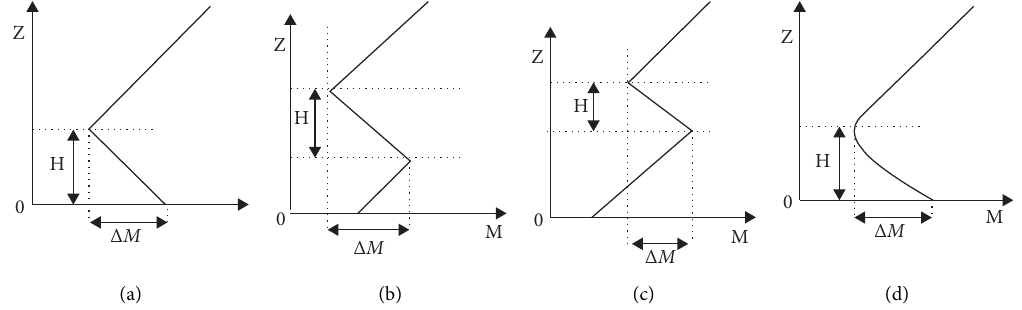
Figure 1: Categories of atmospheric ducts: (a) surface duct, (b) surface-based duct, (c) elevated duct, and (d) evaporation